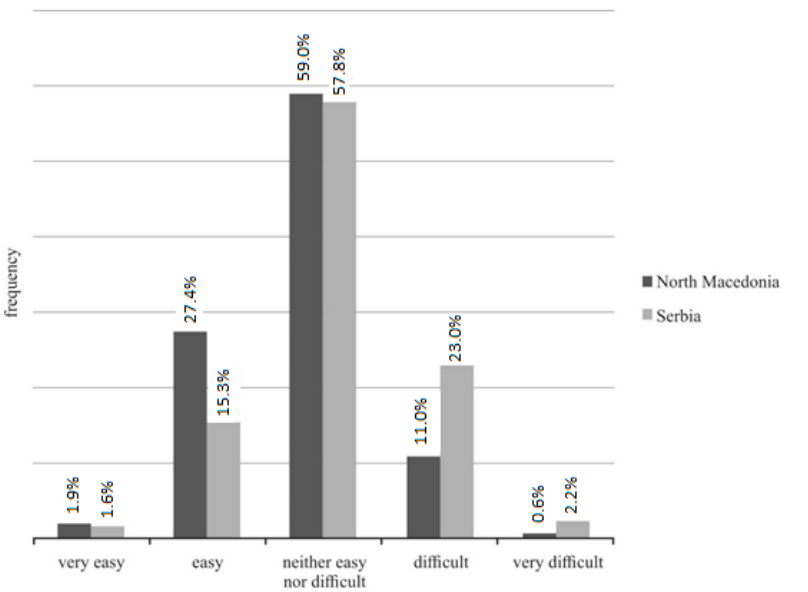
Table 6. The values of the Mann–Whitney U-test for comparing differences in the perceived mental effort of Serbian and North Macedonian students for observed concepts.